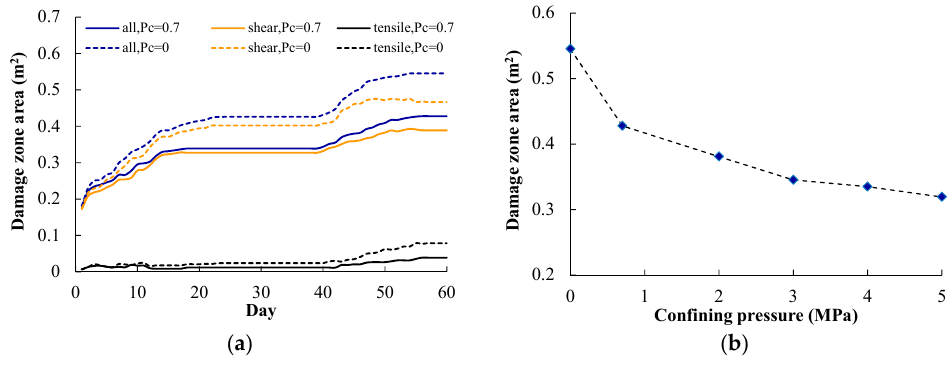
Figure 15. ( a ) Damage variation with P c of 0 and 0.7 MPa; ( b ) damage variation with P c of 0, 0.7, 2, 3, 4 and 5 MPa.